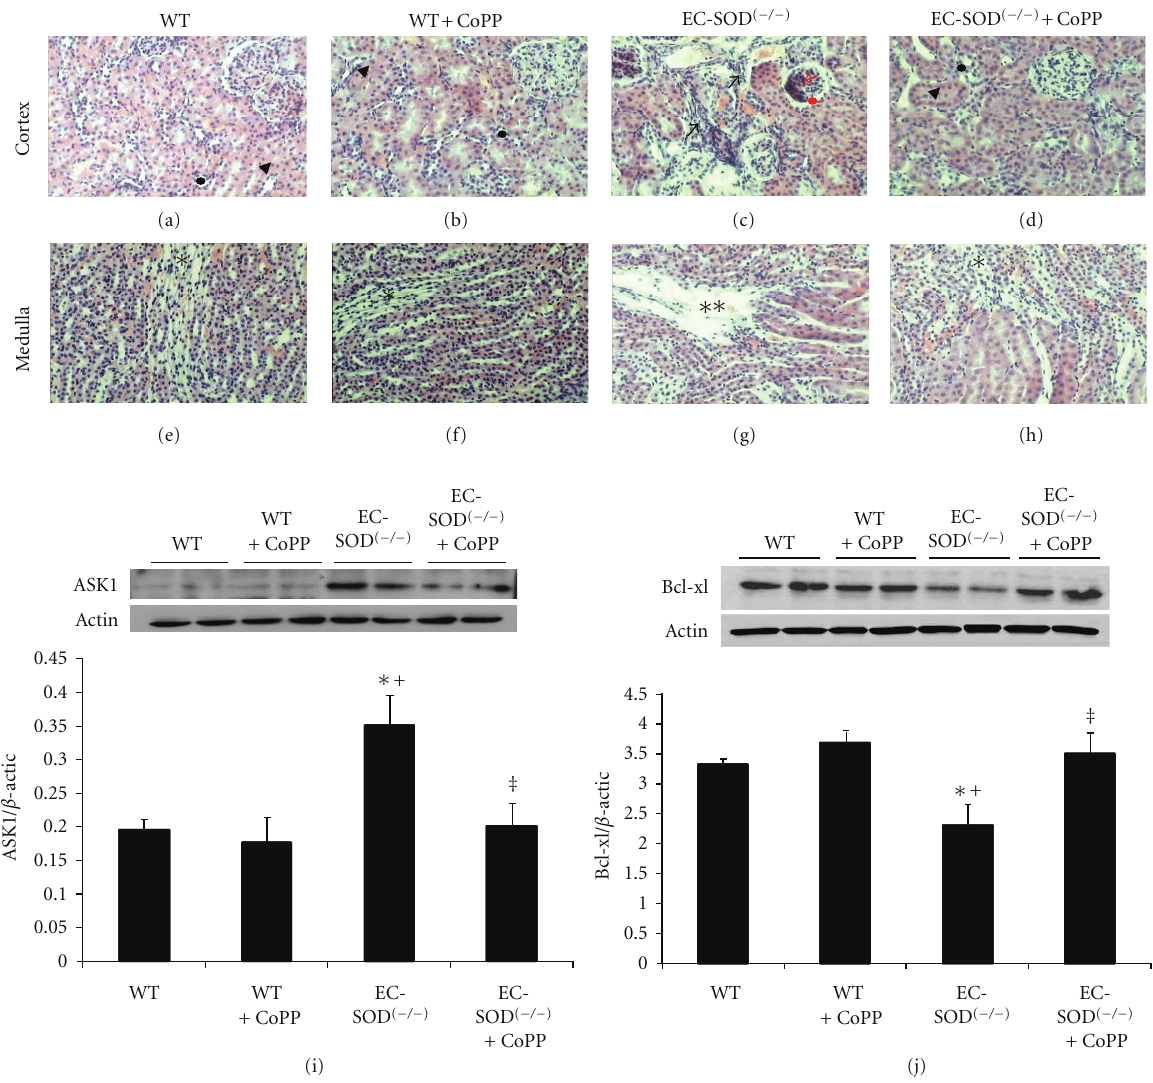
Figure 2: Representative images of renal parenchyma (haematoxylin-eosin staining, 200X) in EC-SOD ( − / − ) and WT mice. WT mice and WT mice treated with CoPP showed no significant morphologic alterations both in cortex (arrow’s head for proximal tubules and black point for distal tubules) and medulla (asterisk for vasa recta) ((a), (b), (e), (f)). EC-SOD ( − / − ) mice displayed tubular damage, hyperproliferation in the glomerulii (red arrows) with Bowman’s capsule dilatation (red point), infiltrates (black arrows) and breakage of vasa recta in outer and inner medulla (double asterisks). ((c), (g)). Tubular interstitial and microvascular pathology are abrogated in CoPP-treated EC-SOD ( − / − ) mice ((d), (h)). Western blot analysis of (i) ASK1 (j) BCL-xl protein expression in kidney of WTmic, EC-SOD ( − / − ) mice, and mice treated with CoPP. Quantitative densitometry evaluation of Bcl-xl, ASK-1-to- β -actin ratio was determined. Blots are representative of four separate experiments. Results are expressed as mean ± SE, ∗ P < 0 . 05 versus WT, + P < 0 . 01 versus WT + CoPP, ‡ P < 0 . 05 versus EC-SOD ( − / − )